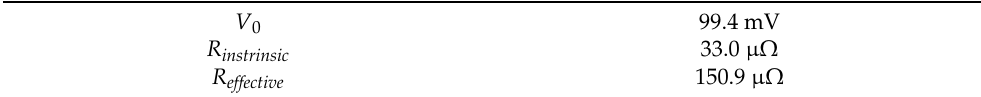
Figure 7. Equivalent circuit of the dynamo flux pump supplying the field winding of the HTS generator. Table 3. Dynamo flux pump — equivalent circuit parameters.